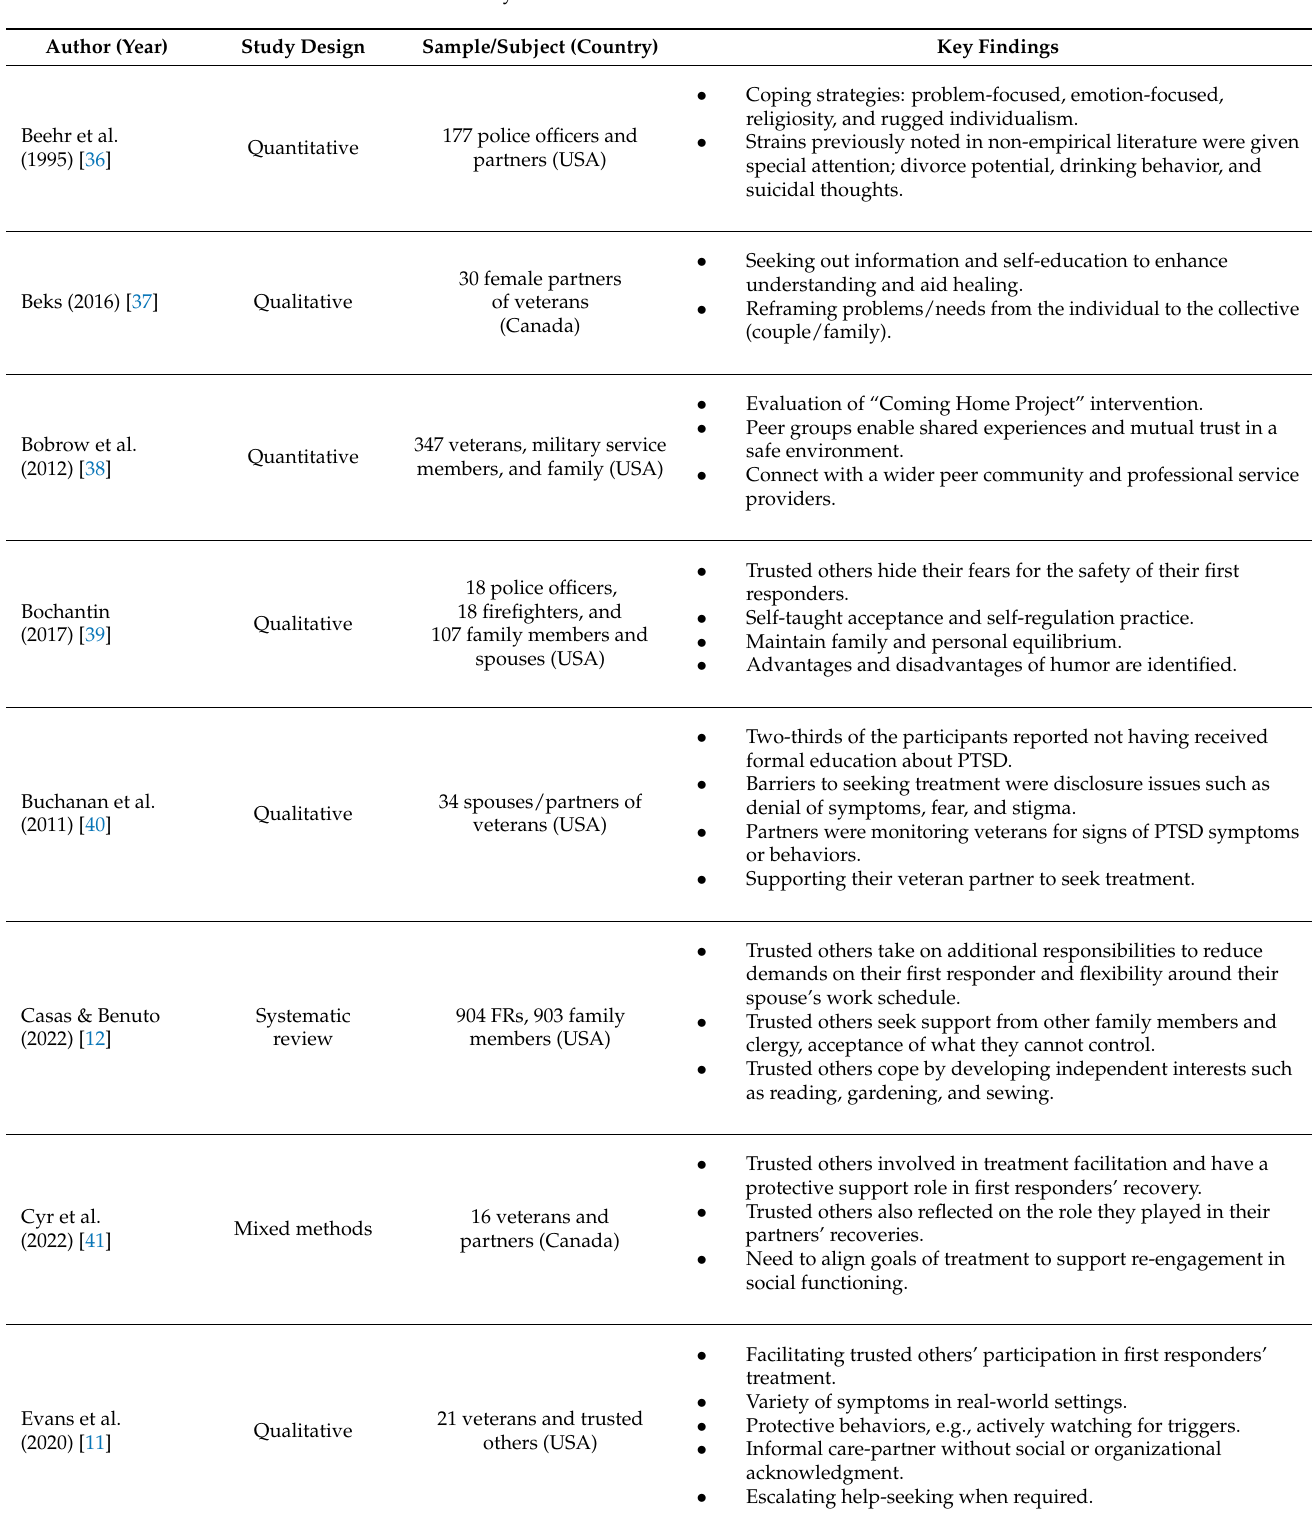
Table 2. Summary of articles included in the narrative